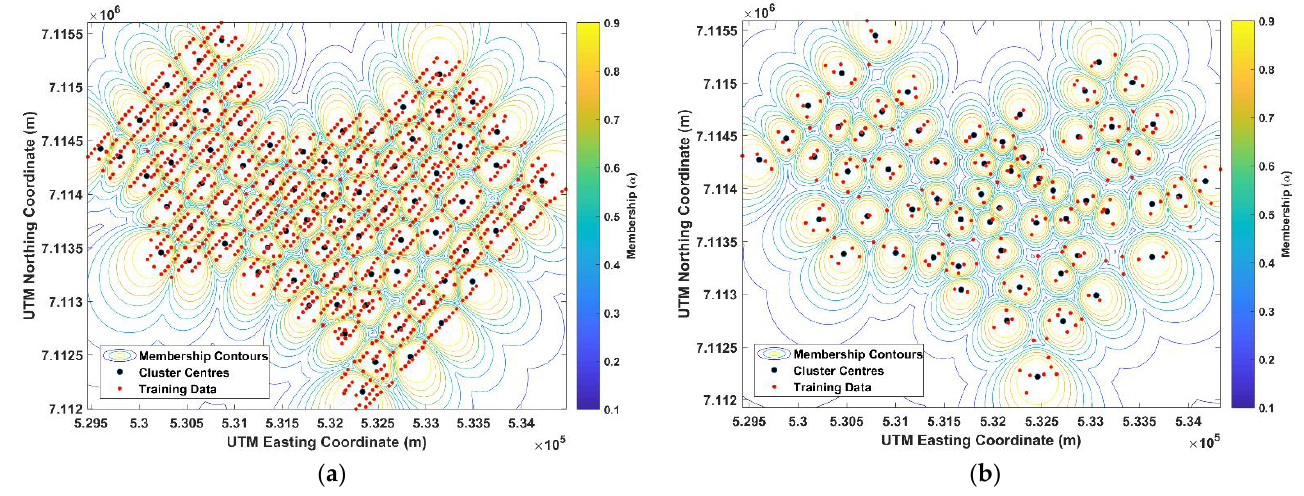
Figure 7. ( a ) Visual representation of clustered data for training increment A and ( b ) training increment F.